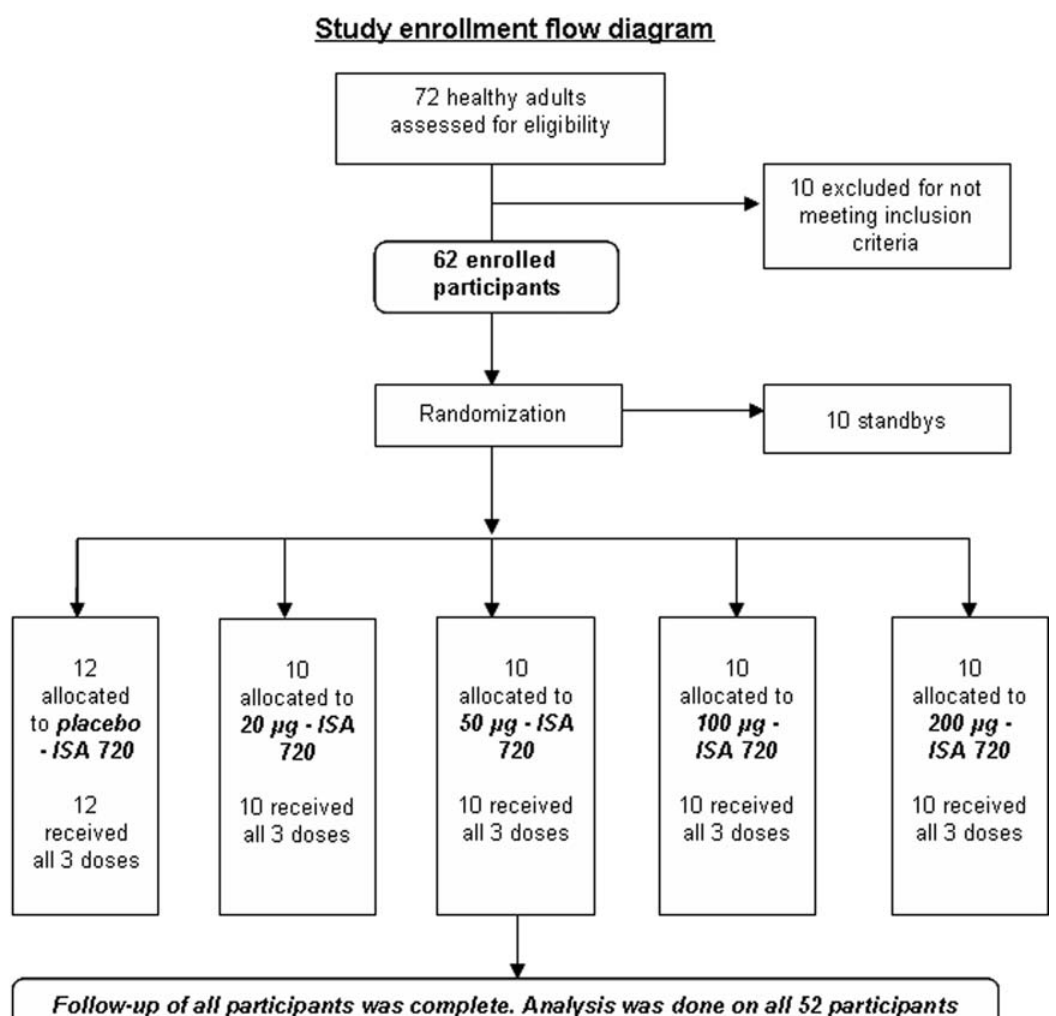
Figure 1. Study enrollment flow diagram.